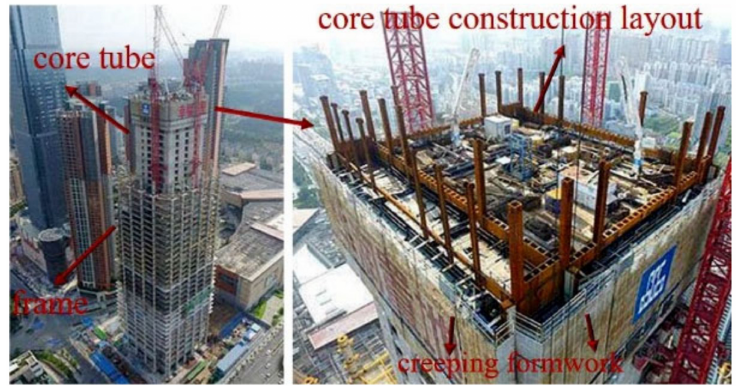
Figure 1. Frame-core tube building in